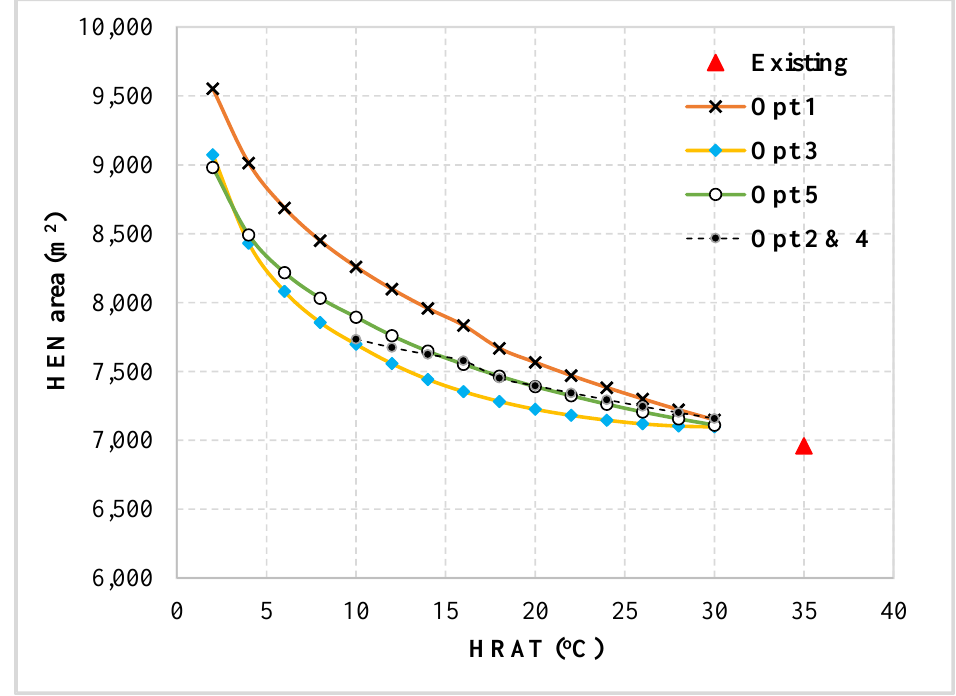
Figure 3. Total HEN area based on HRAT for path combination options.